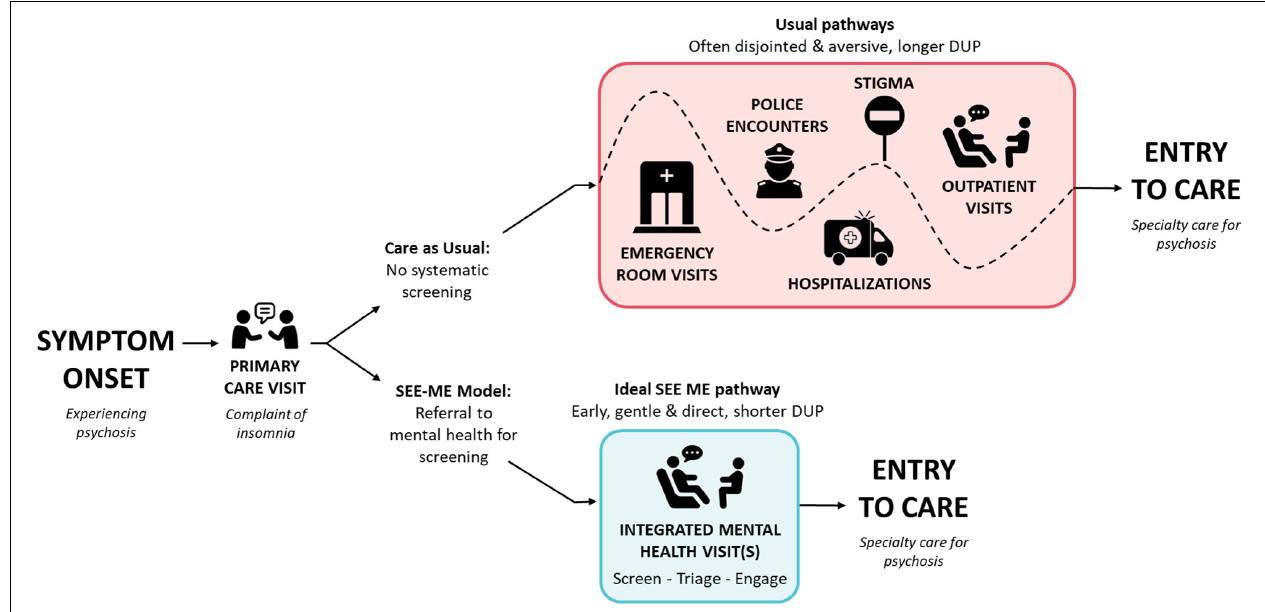
FIGURE 1 | Targeted impact of SEE ME on pathways to care. Since SEE ME seeks to identify acute psychosis as well as high psychosis risk, the time from psychosis onset to specialty care represents the Duration of Untreated Psychosis (DUP) for individuals with psychotic disorders and Duration of Untreated Illness (DUI) for individuals identified during an at risk state. Those at risk who transition to a psychotic disorder would have a subsequent